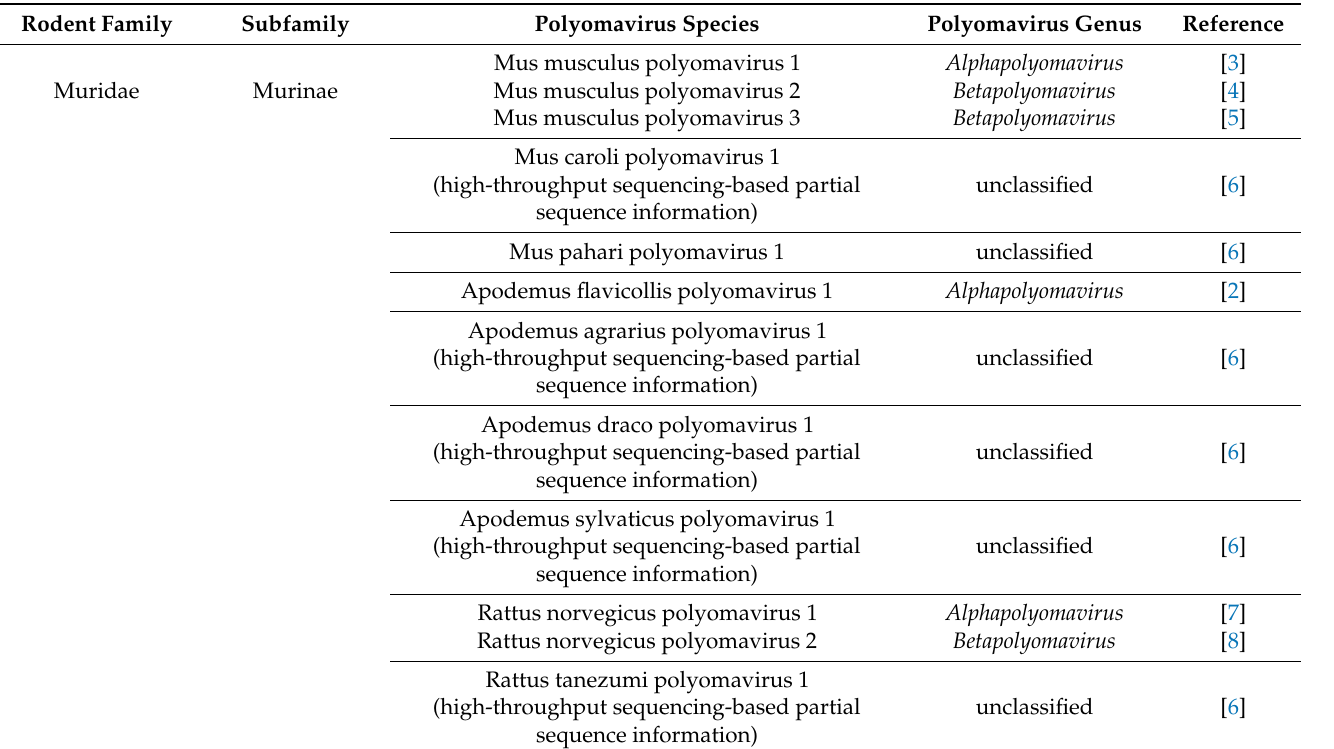
Table 1. Overview about rodent-associated